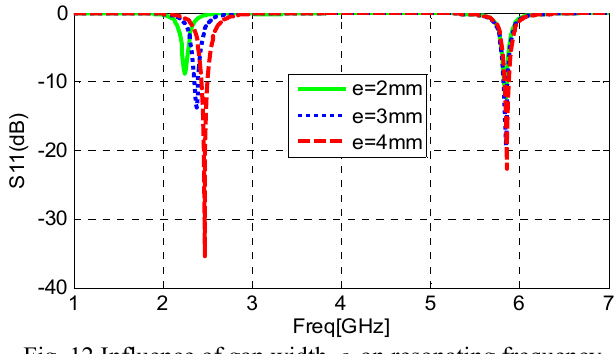
Fig. 12 Influence of gap width e on resonating frequency